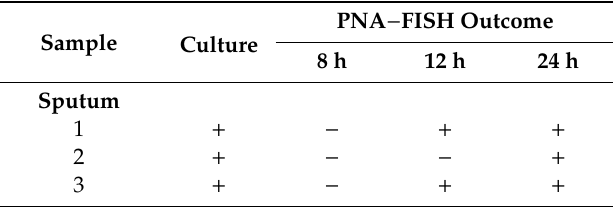
Table 3. PNA-FISH results regarding A. fumigatus detection in nine artificially contaminated